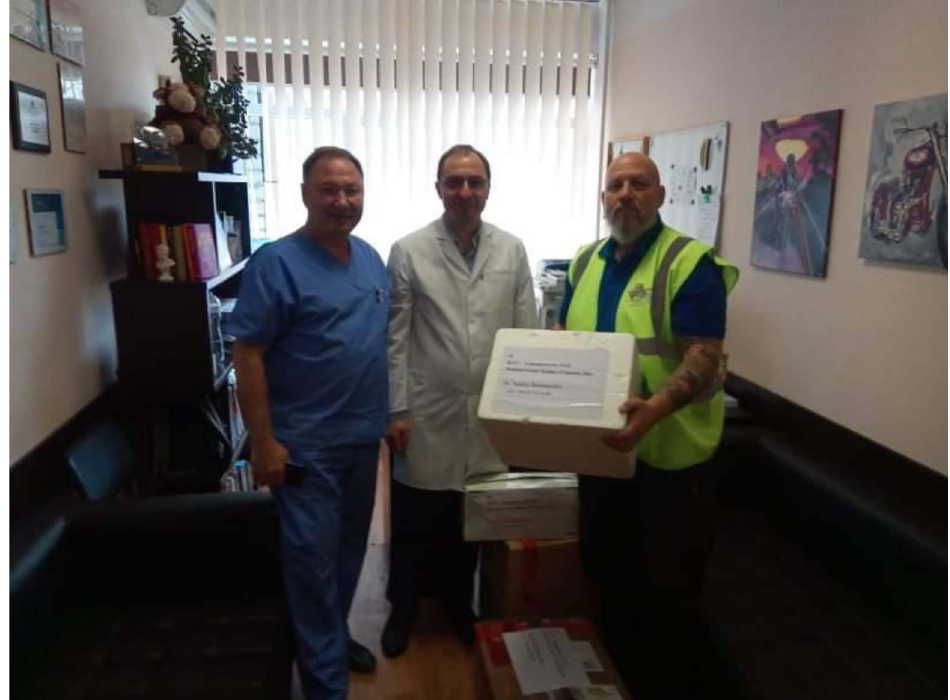
Figure 4. Handing over chemotherapy at Bogomolets National Medical University (NMU) Kyiv, Ukraine by Austrian Veterans. From left to right: Professor Dr. Anatolii Shudrak, Deputy Chief Physician of National Cancer Institute, and Professor Dr. Andriy Beznosenko, Director National Cancer Institute, and Max Pollak, Veterans, Green Knights MMC, Chapter 147, Austria. Each individual at the picture gave permission, that the picture is